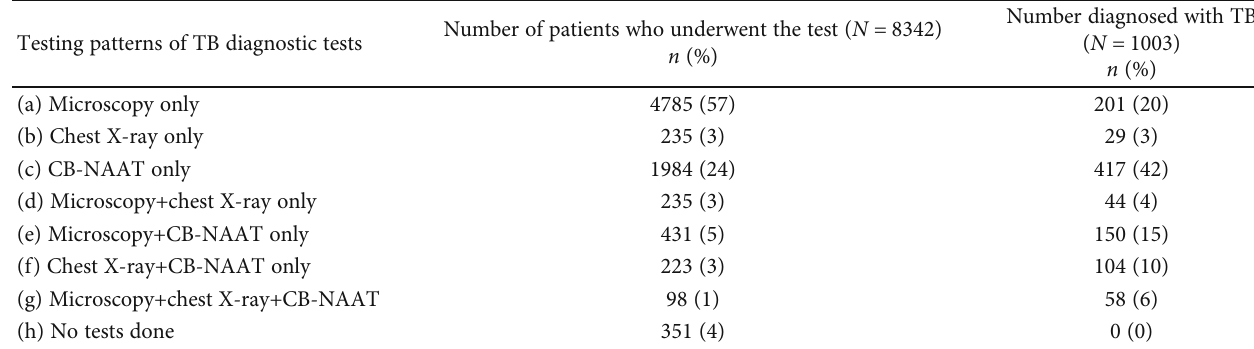
Table 6: The testing patterns of TB diagnostic tests performed, number of patients who underwent tests and those diagnosed with TB under RIPENED project, Telangana State, India, during 2018-19 ( N = 8342 ). Testing patterns of TB diagnostic tests